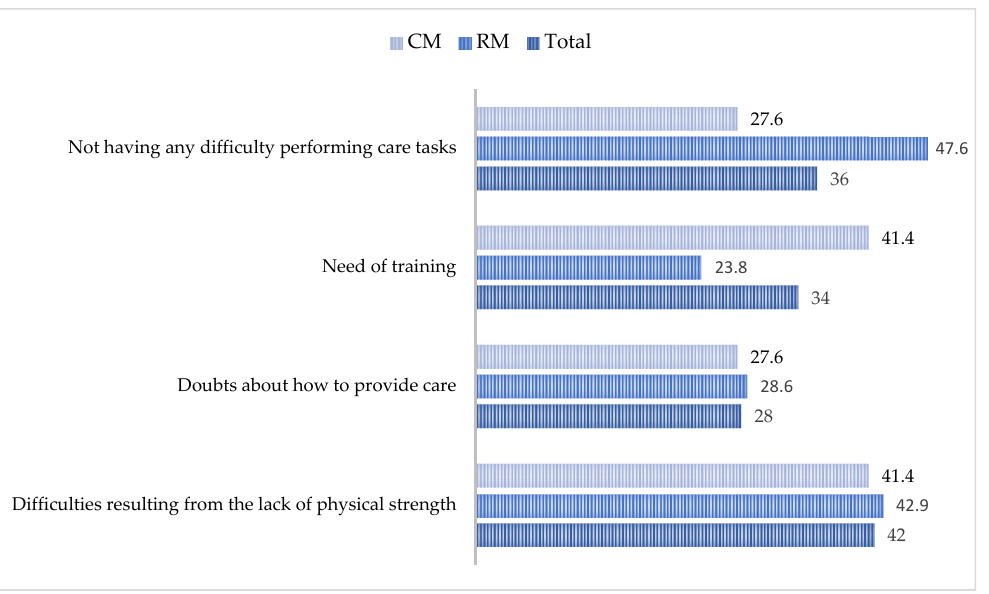
Figure 3. Percentages of the perceptions of informal caregivers about the tasks derived from care. RM = remote monitoring; CM = conventional monitoring.